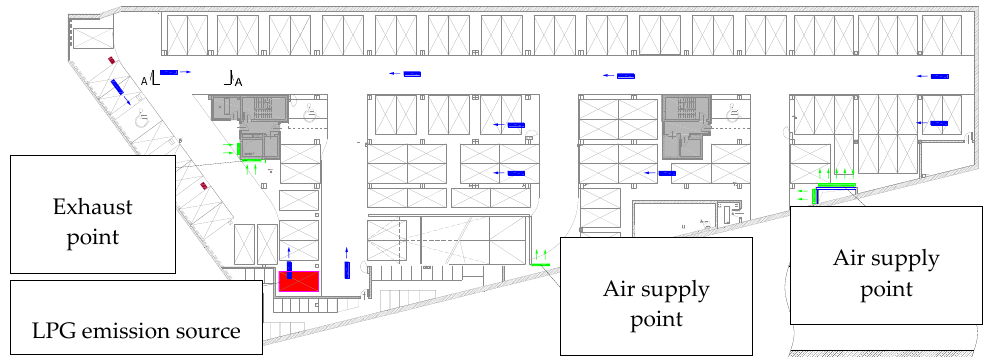
Figure 16. The ventilation system scheme in a real car park.